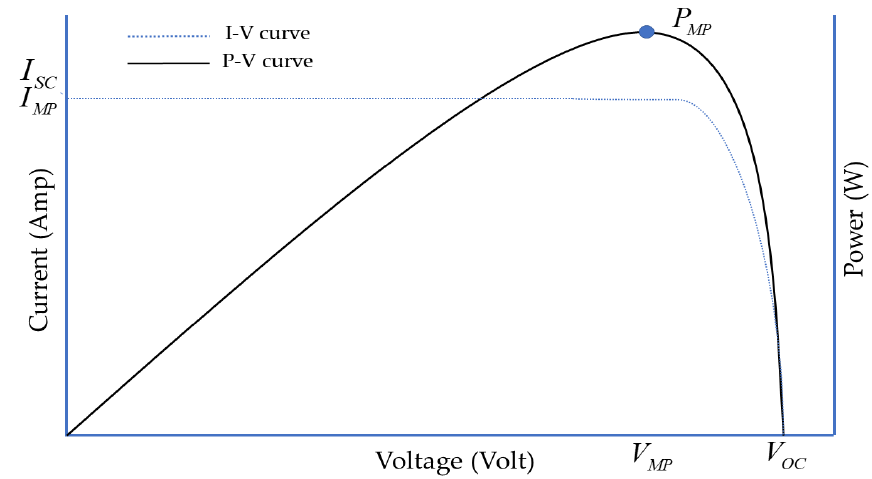
Figure 5. Ideal shape of solar cell I-V and P-V characteristic curves [116].